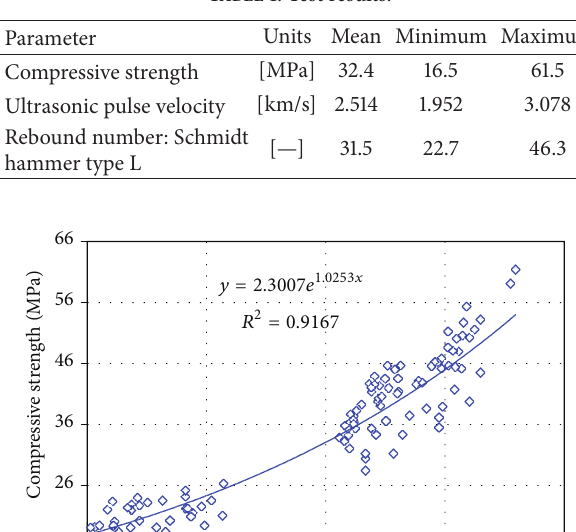
Table 1: Test results.